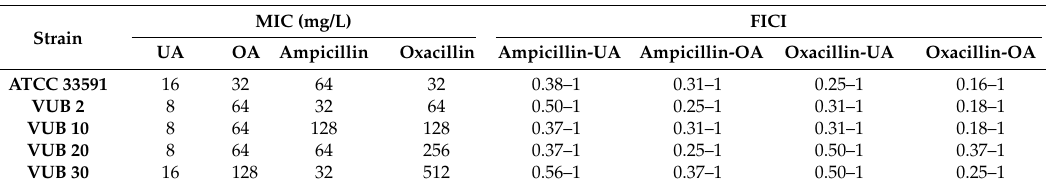
Table 1 . Antimicrobial activity of ursolic acid (UA), oleanolic acid (OA) and β‐ lactams on MRSA strains and FIC index (FICI) of their combinations. Table 1. Antimicrobial activity of ursolic acid (UA), oleanolic acid (OA) and β -lactams on MRSA strains and FIC index (FICI) of their